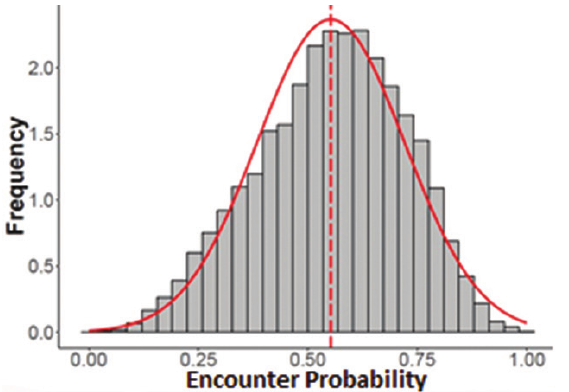
Figure 7. Frequency histogram showing encounter probability for all spatial grains (n=66,902). The y-axis is a proportional scale (2=3000). Data collected from Lyme Park, Disley, UK, in 2018. Faecal cortisol